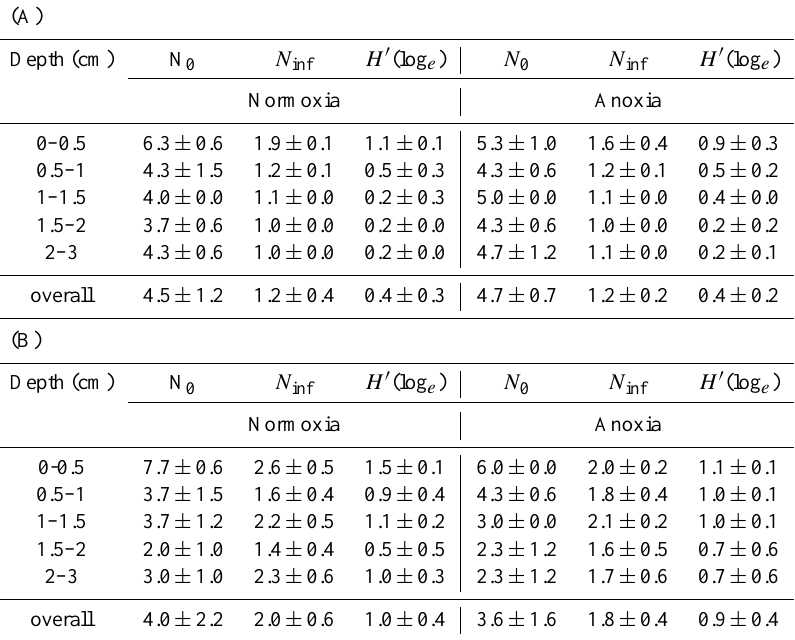
Table 1. Average Hill’s diversity indices ( ± stdev) for (A) meiofauna taxa and (B) copepod family composition in the field experiment. N 0 = number of taxa; N inf = dominance index; H 0 (log e ) = 6P 2 log( P i ) ; N = Normoxia; A = Anoxia; sediment depth layers indicated in i cm. Averaged values ( ± stdev) over all depth